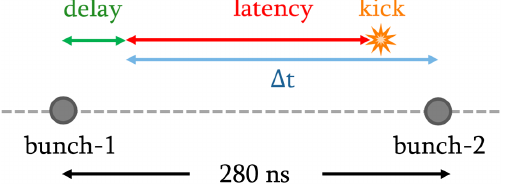
FIG. 14. Schematic illustrating the principle of the direct latency measurement by adding a controlled delay to the kicker drive output signal.